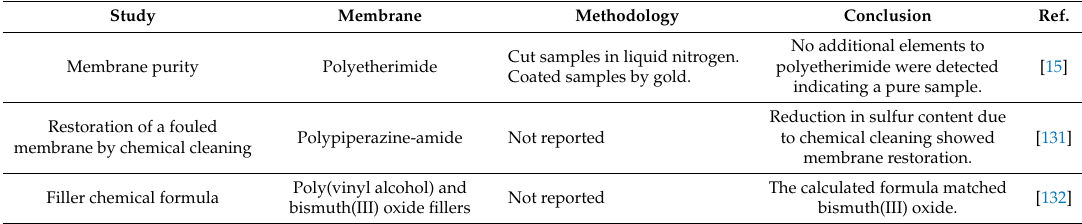
Figure 29. Atom excitation by electron and the release of -rays for EDS analysis [133]. Table 10. Characterization of polymeric membranes by